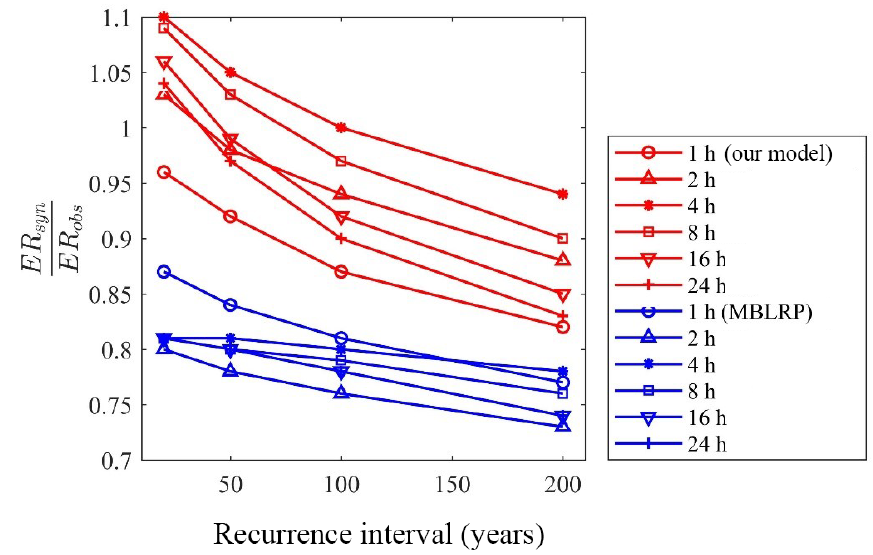
Figure 14. Degree of over- or underestimation of extreme values by our model (red) and the traditional MBLRP model (blue). ER syn and ER obs are extreme rainfall values estimated from synthetic rainfall and observed rainfall,